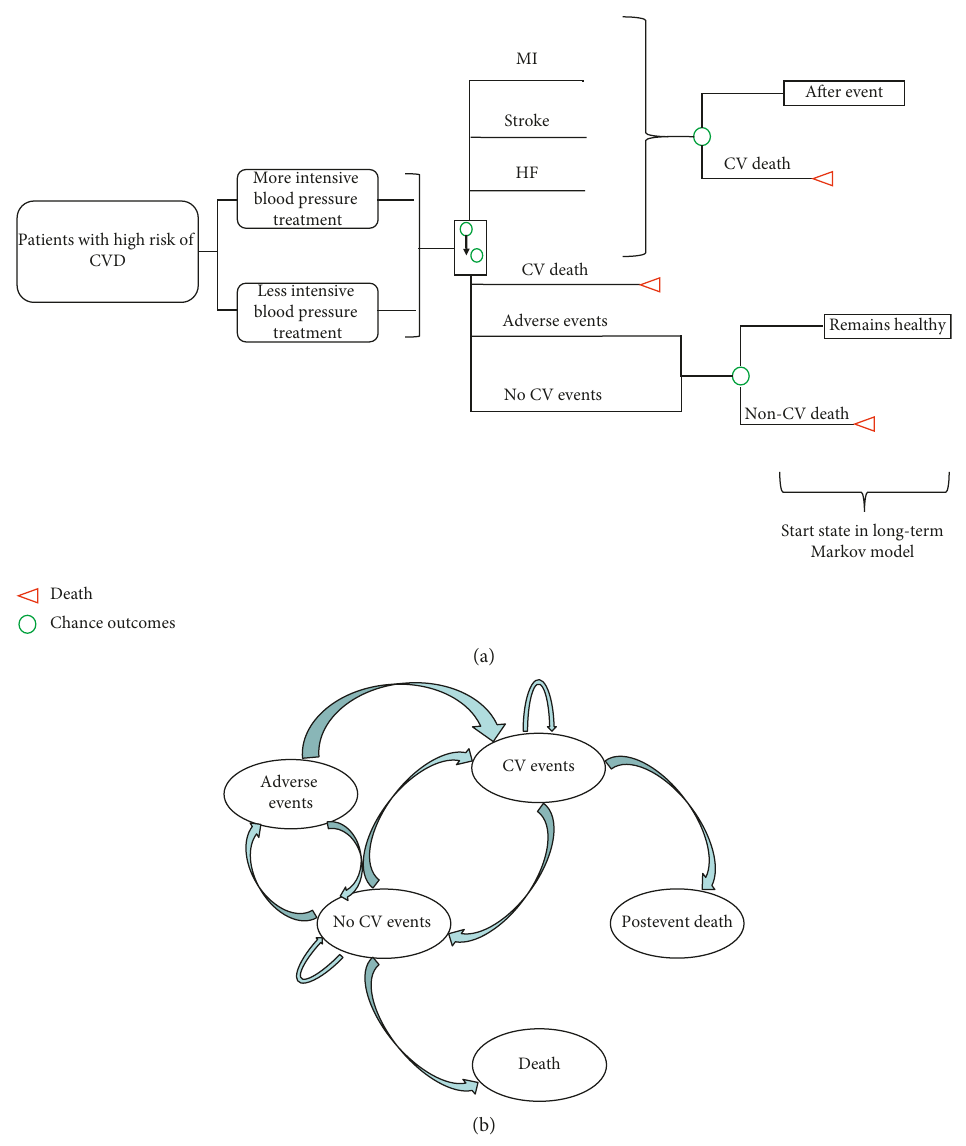
Figure 1: Long-term Markov extrapolation model. (a) Markov model, indicating BP-lowering strategies and possible transitions to CV event states. Abbreviations: MI, myocardial infarction; HF, heart failure; CV, cardiovascular. Green circles represent chance outcomes; red triangles are terminal states. After each cycle, patients either remain healthy or experience a clinical event (MI, stroke, HF, and death, or adverse events). (b) Long-term Markov extrapolation